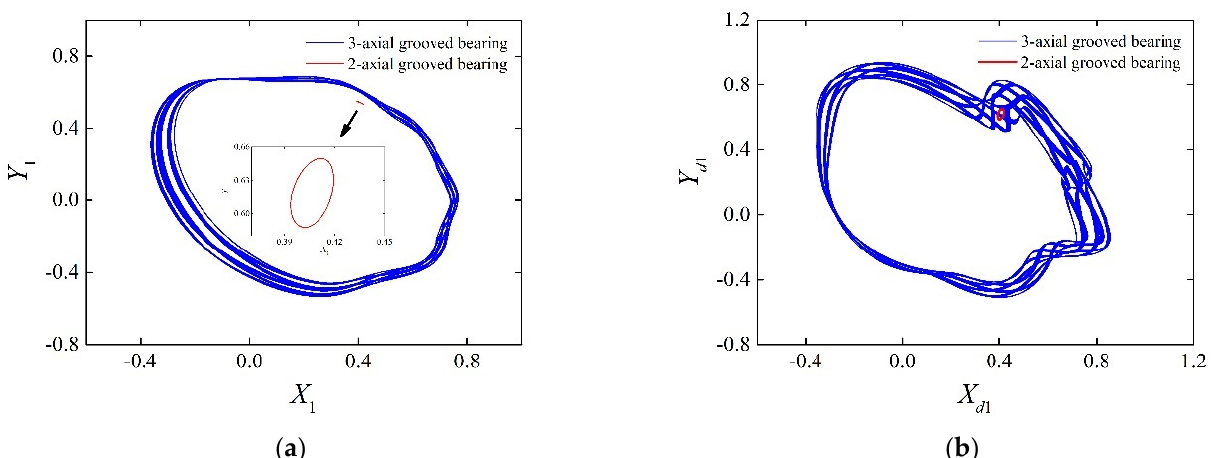
Figure 14. When ω = 2000 rad/s, comparison of the rod–fastened rotors with 3-axial grooved and 2-axial grooved gas bearings, ( a ) comparison of the orbits at the left bearing station; ( b ) comparison of the orbits at the left disk station.